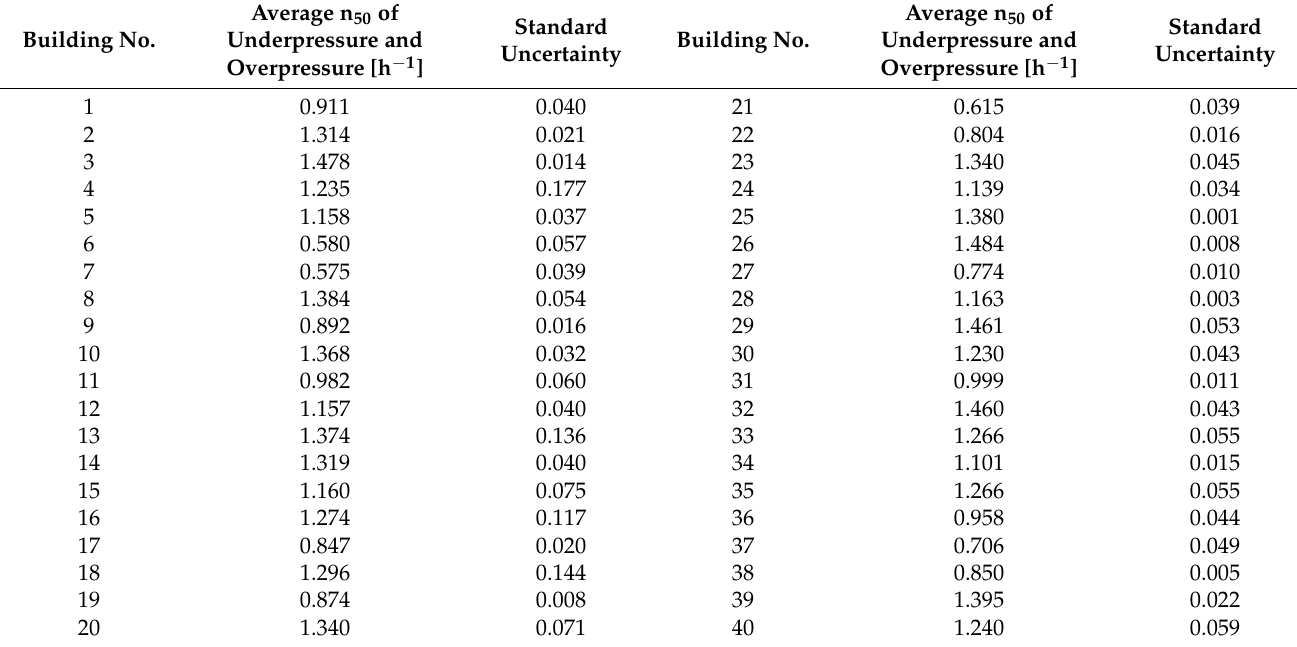
Table 8. Summary of test